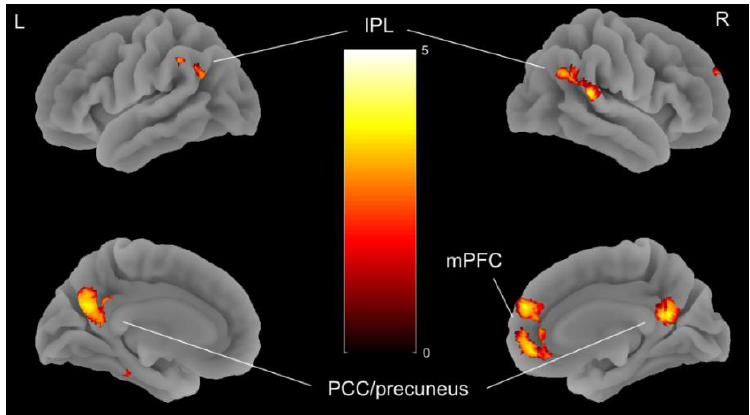
Figure 3. Family-wise error (FWE) rate corrected ( p < 0.05) brain map showing regions in which blood-oxygen-level-dependent (BOLD) signal deactivation associated with executive decision-making during delay discounting (regressor 1) was less pronounced in AN, following partial weight restoration (i.e., time point 2 (TP2) > time point 1 (TP1)), indicating a relative activation increase. T -map values are plotted on a 3 dimensional (3D) surface rendering of an individual brain normalized to the Montreal Neurological Institute template. AN = anorexia nervosa; mPFC = medial prefrontal cortex; IPL = inferior parietal lobe; PCC = posterior cingulate cortex. L = left; R = right.